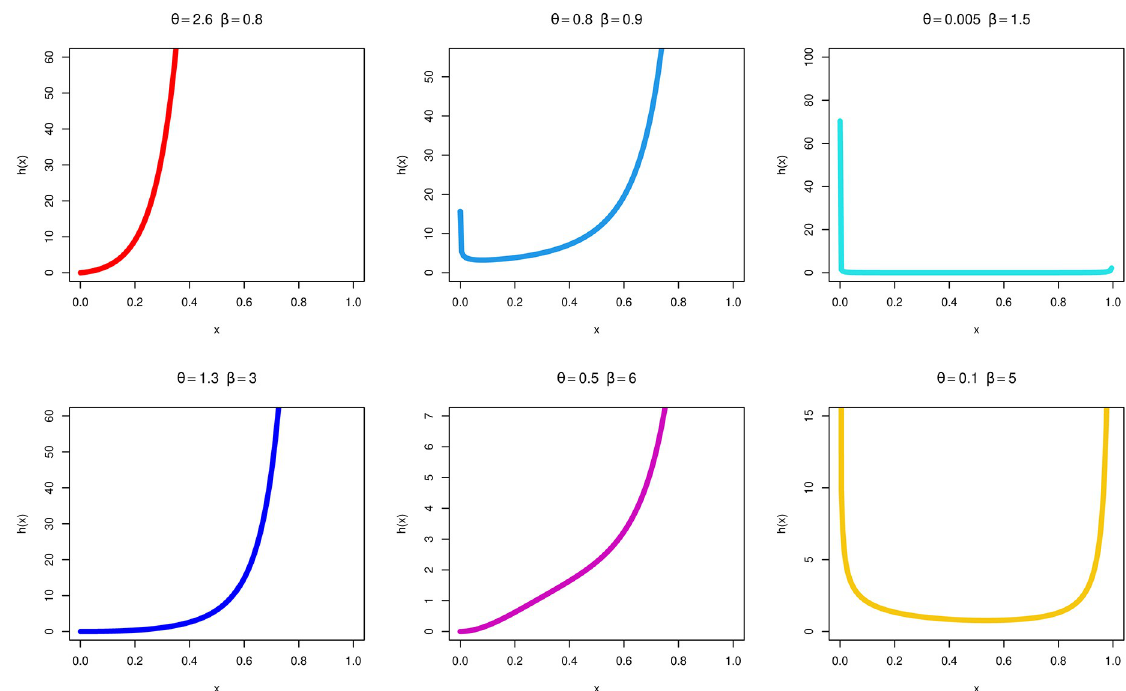
Fig 2. hr of the MKTL distribution for certain parameter